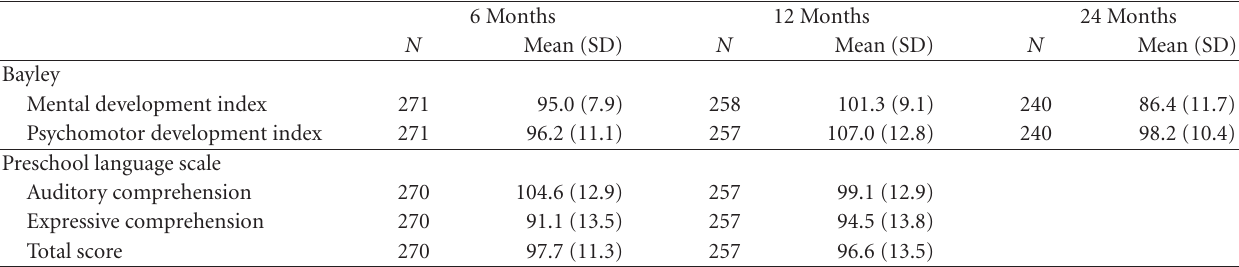
Table 2: Mean scores on neurodevelopmental scales at 6, 12, and 24 months of age.